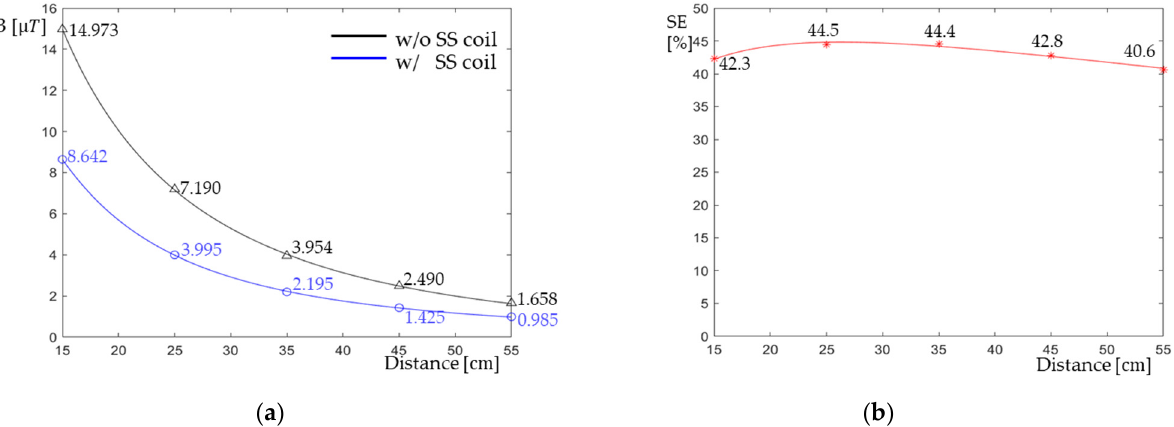
Figure 18. Experimental results of the leakage magnetic field reduction performance: ( a ) Comparison of the leakage magnetic field. ( b ) Comparison of the shielding effect.